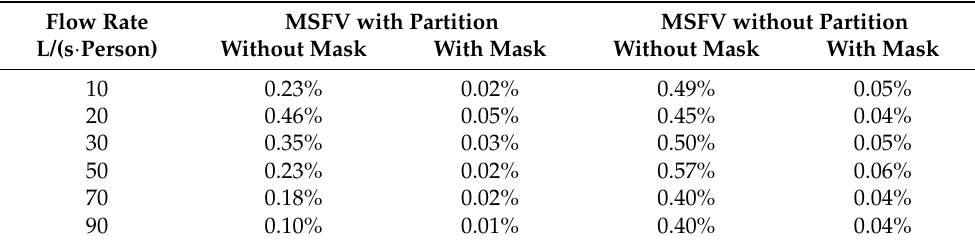
Table 3. Inhaled fraction of the medical staff under the MSFV with and without partitions IF × 100%. Flow Rate MSFV with Partition MSFV without